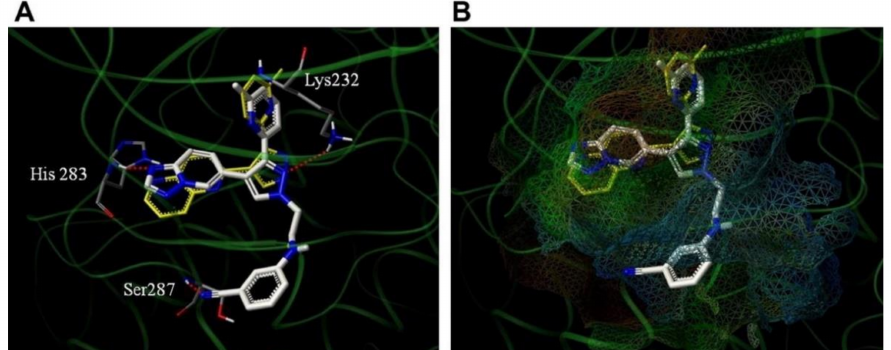
Figure 89. Putative binding mode of compound 80 with ALK5. ( A ) White, 80 (cid:48) s binding mode in the active site; Yellow, 1,5-napthyrine; Grey, key amino acid residues represented in line form; Red, hydrogen bond interaction (<2.8 Å); compound 80 is superimposed over 1,5-naphthyrine inhibitor. ( B ) MOLCAD49 lipophilic potential surface map of ALK5’s active site in the docking model of 80 . Lipophilicity increases from blue (hydrophilic) to brown (hydrophobic)